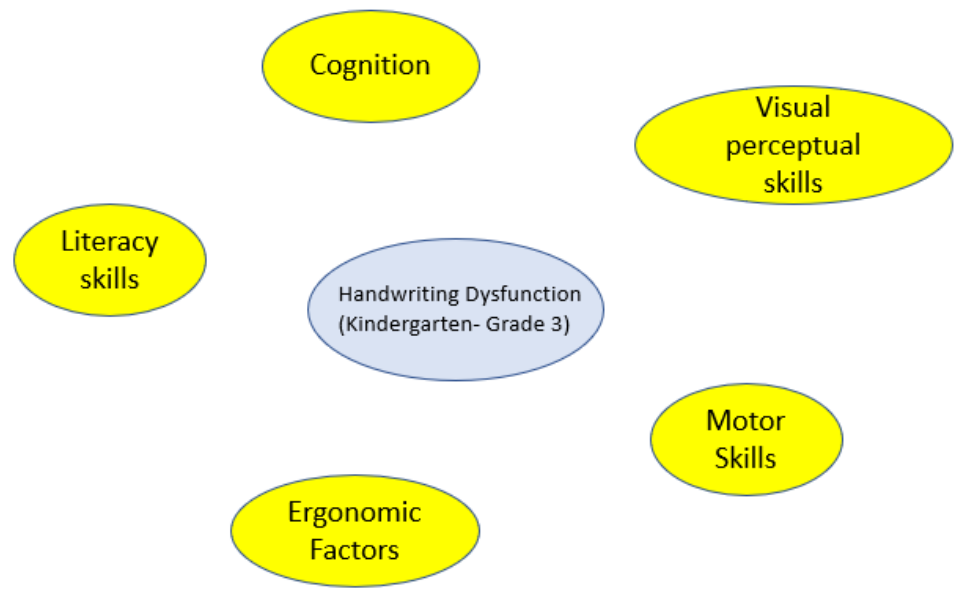
Figure 2. Intuitive factors thought to affect handwriting dysfunction.